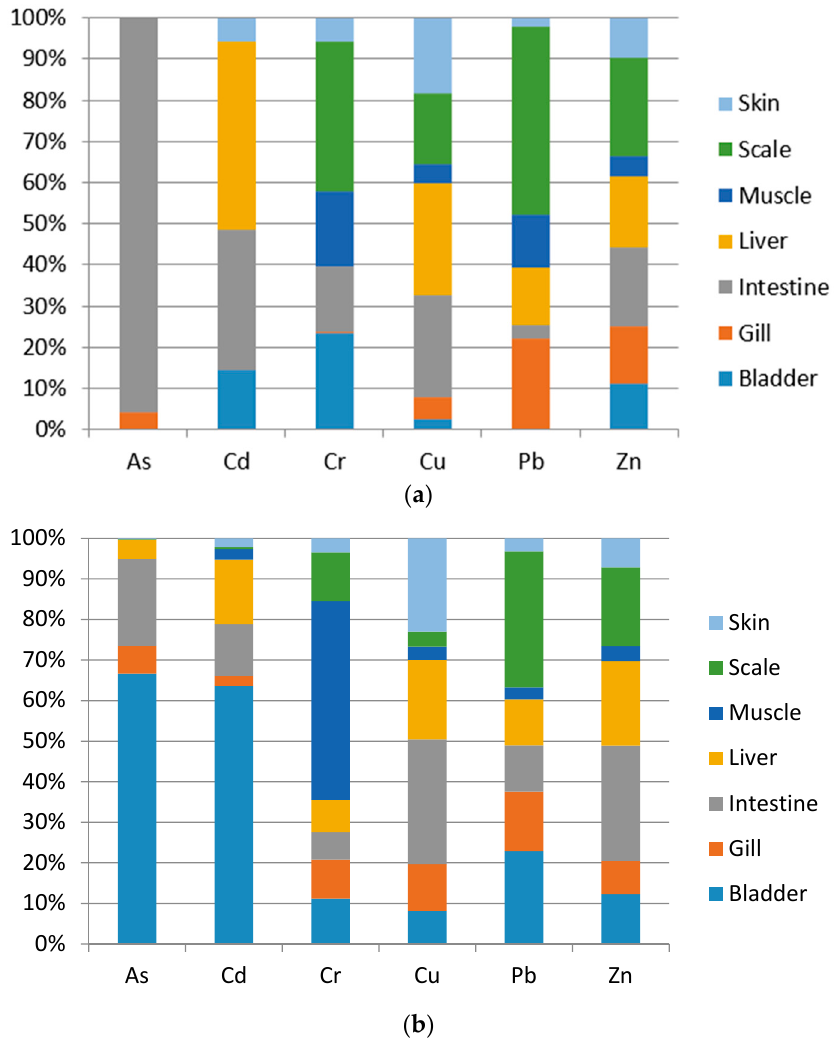
Figure 2. Heavy metals and metalloid concentration (mg/kg wet wt) distribution proportion in different tissues of cultured fish ( a ) and wild fish ( b ).